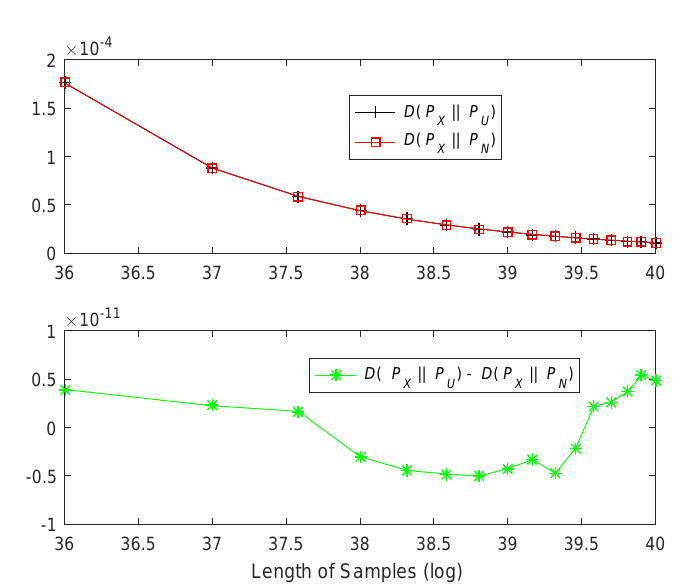
Figure 2: Distances to the uniform distribution and noise distribution